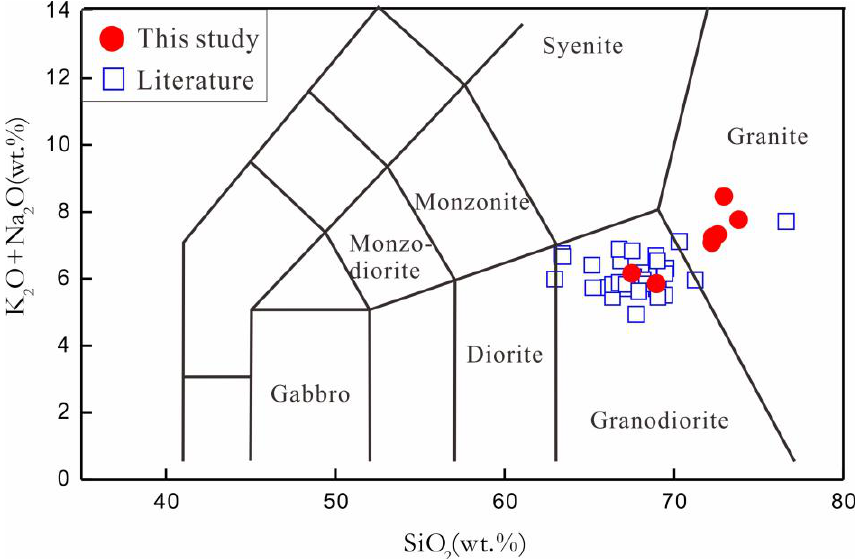
Figure 3. TAS diagram of rock classification of Jiningian granodiorite in the Dahutang deposit (modified after [37]). Previous data from [20,21,38,39], as shown in Supplementary Table S2.